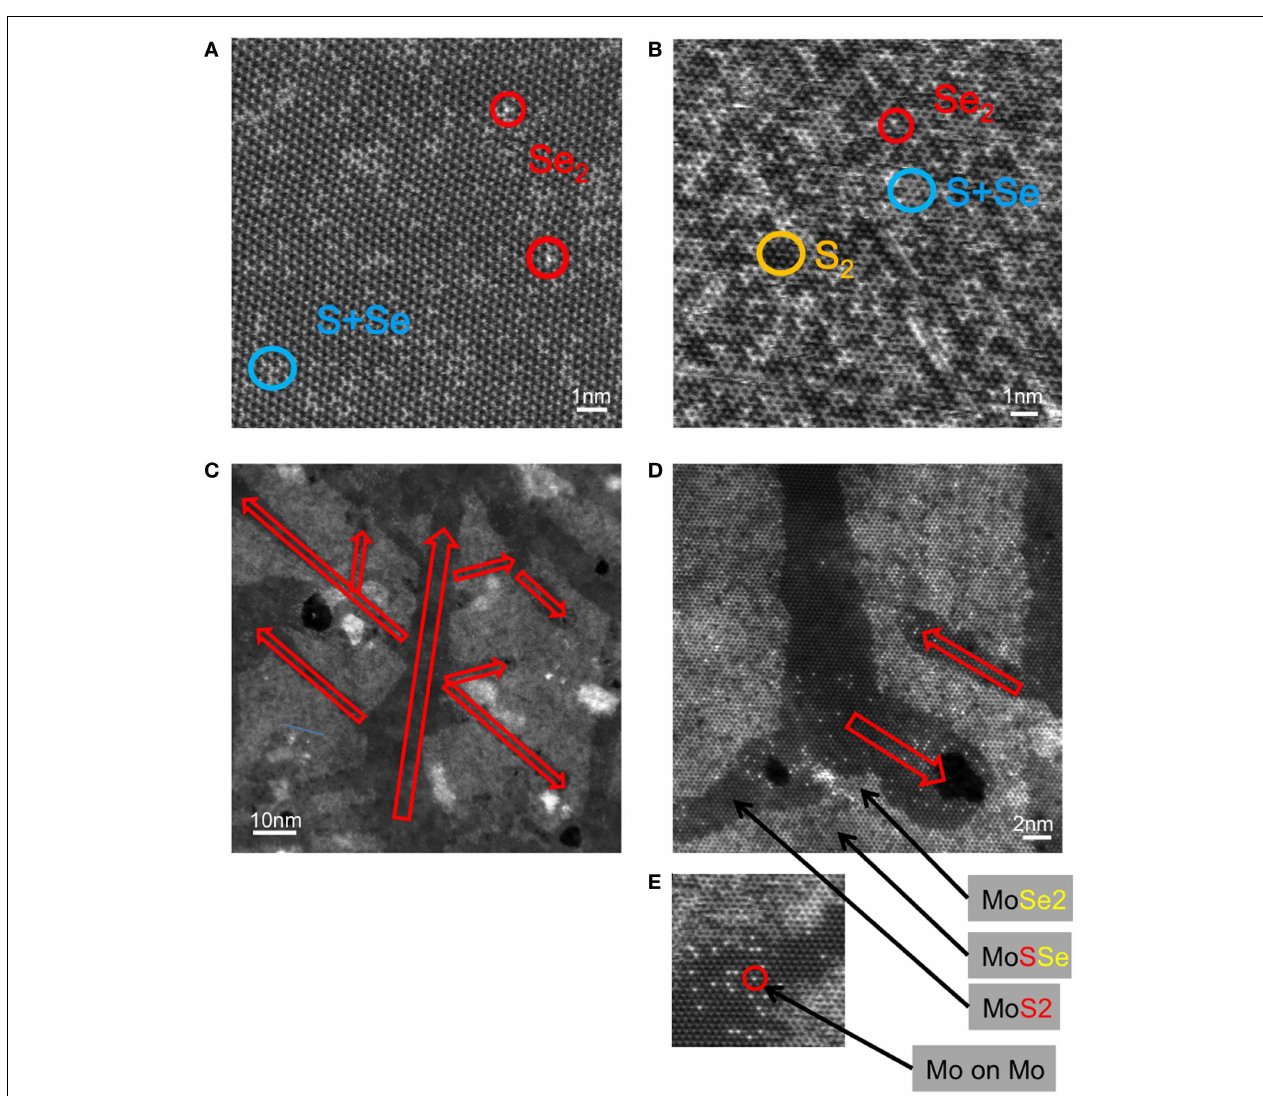
FIGURE 6 |TEM images of the MoS 2 flakes selenized at (A) 600°C and (B) 700°C and (C–E) MoSe 2 sulfurized at 700°C